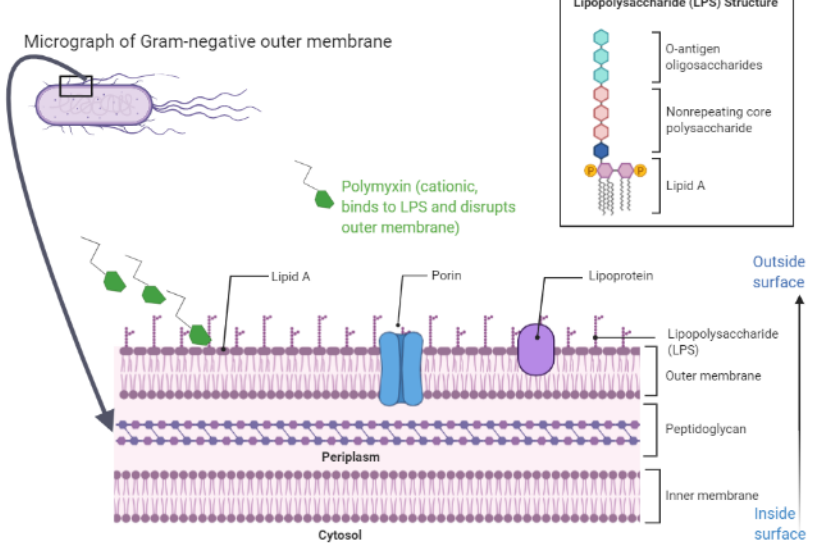
Figure 2. A schematic representation of a Gram-negative cell wall with outer membrane composition. The inner leaflet consists of phospholipids, whereas the outer leaflet shows lipopolysaccharides, lipoproteins and porins. Lipopolysaccharide components are also shown. Cationic polymyxins bind to the negatively charged components of lipopolysaccharides.